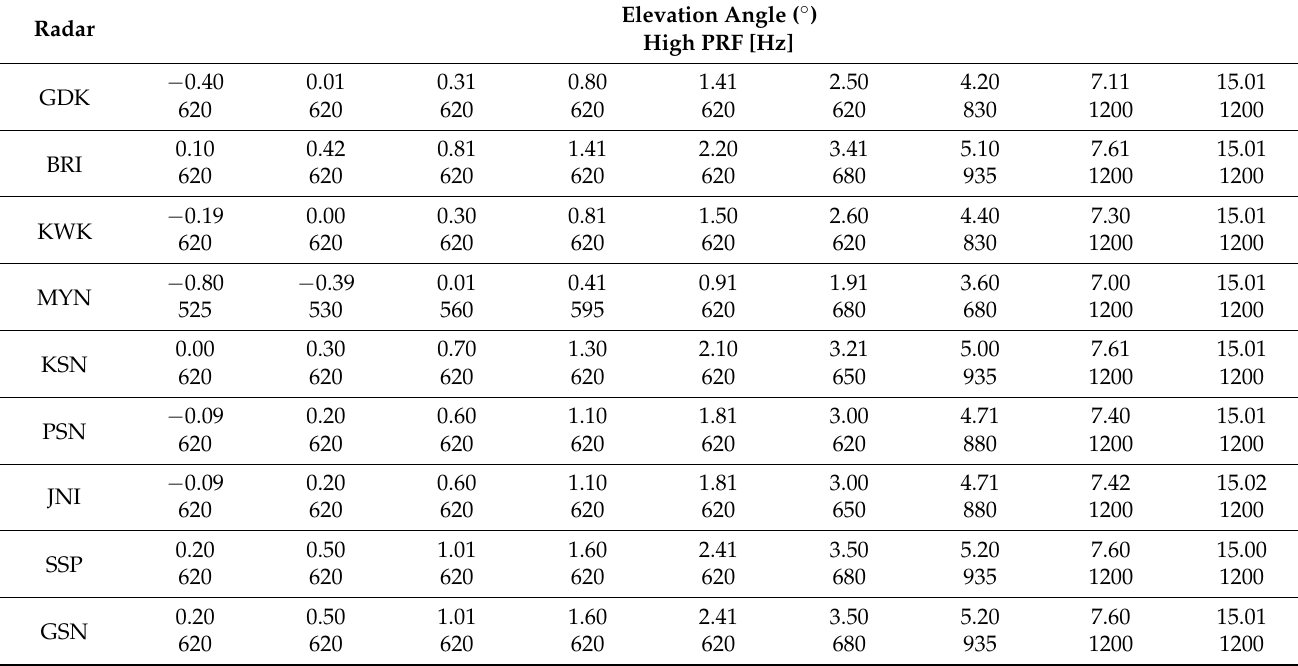
Table 1. Scan strategy of each radar within the KMA network.